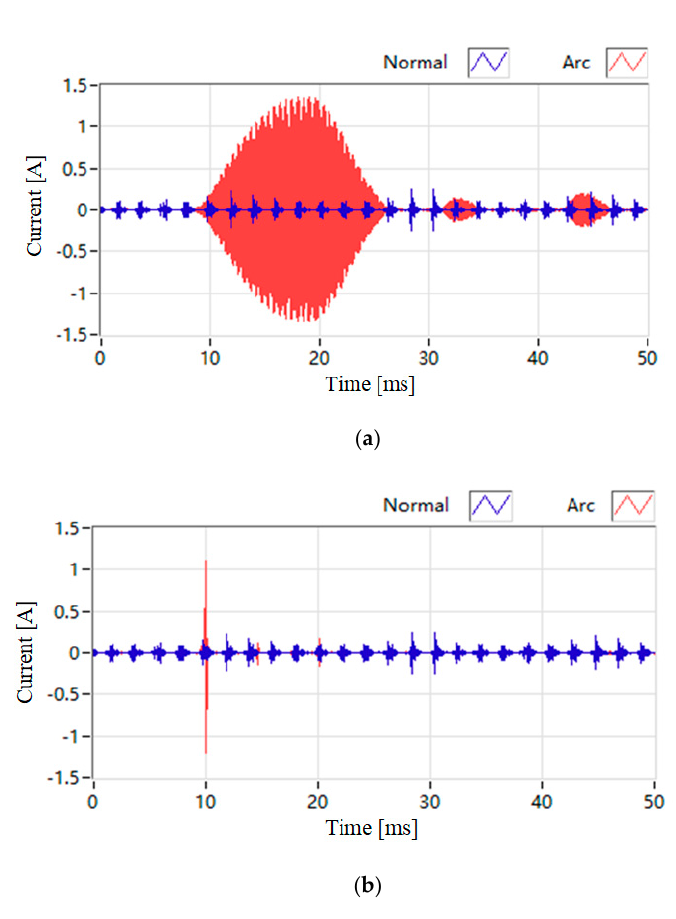
Figure 11. Extraction of the arc signal. ( a ) cord-cord; ( b ) carbon-copper.